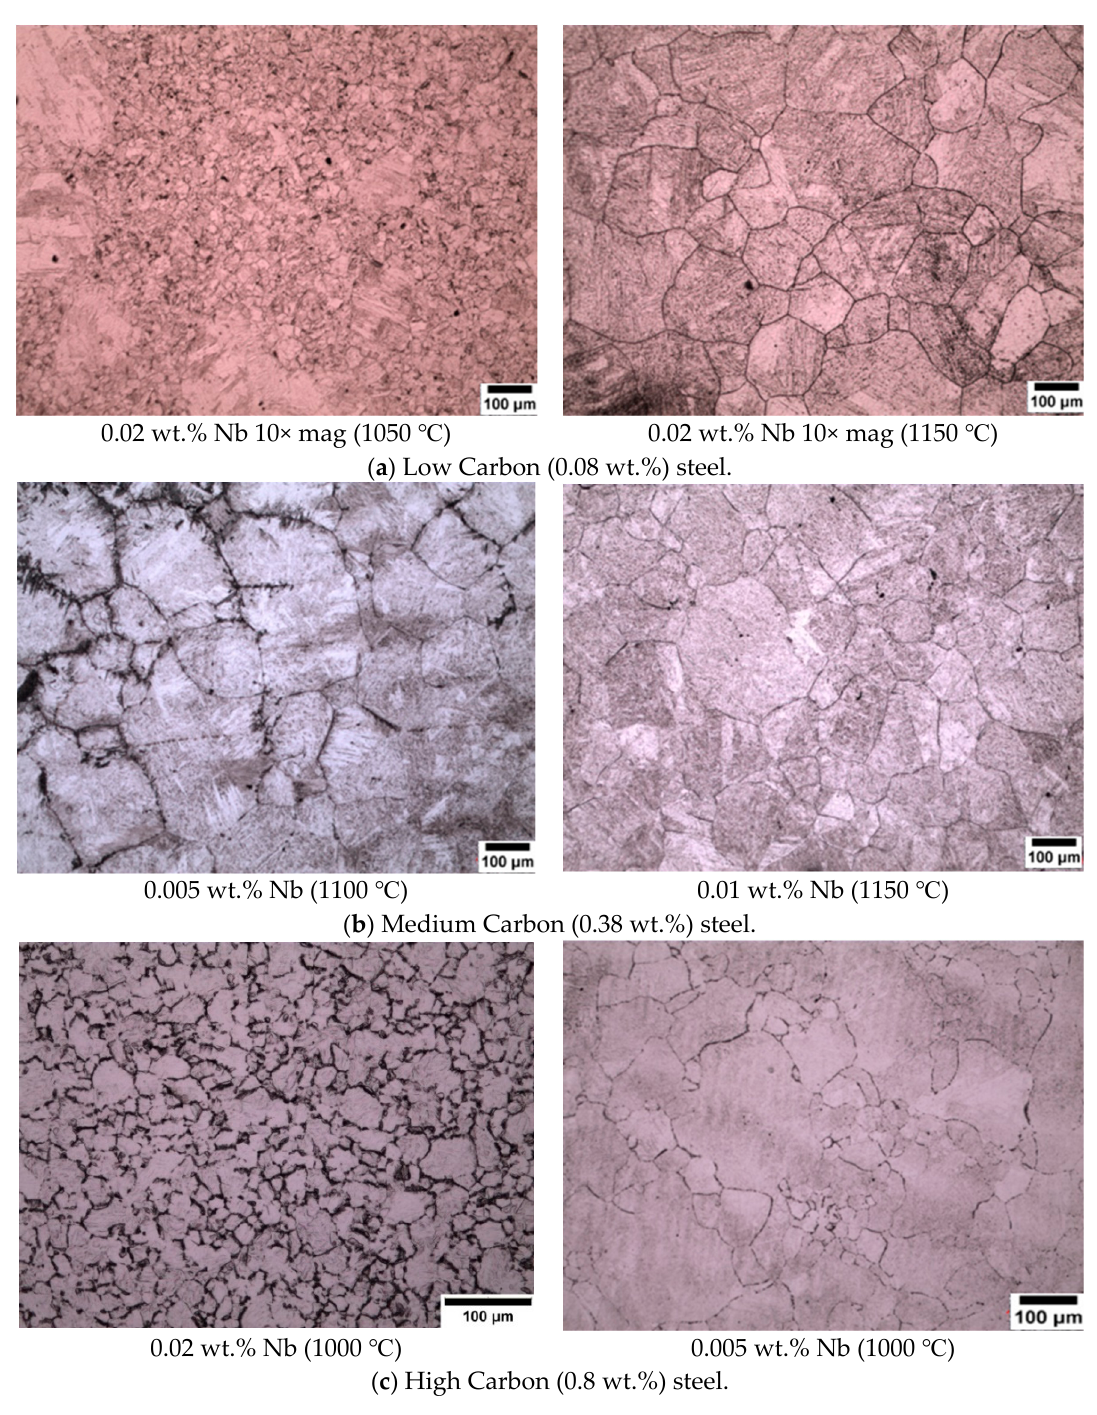
Figure 3. Steel specimens etched with saturated picric acid with sodium dodecyl sulfate (SDS) as a wetting agent used for ( a ) and ( b ) and sodium dodecylbenzene sulfonate for ( c ).